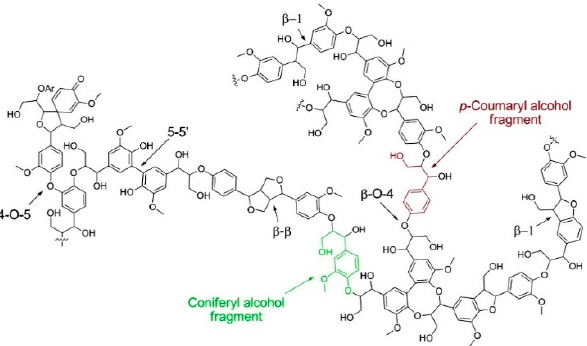
Figure 2. Structure of softwood lignin. Reprinted with permission from Zakzeski et al. [5]. Copyright (2010) American Chemical Society.